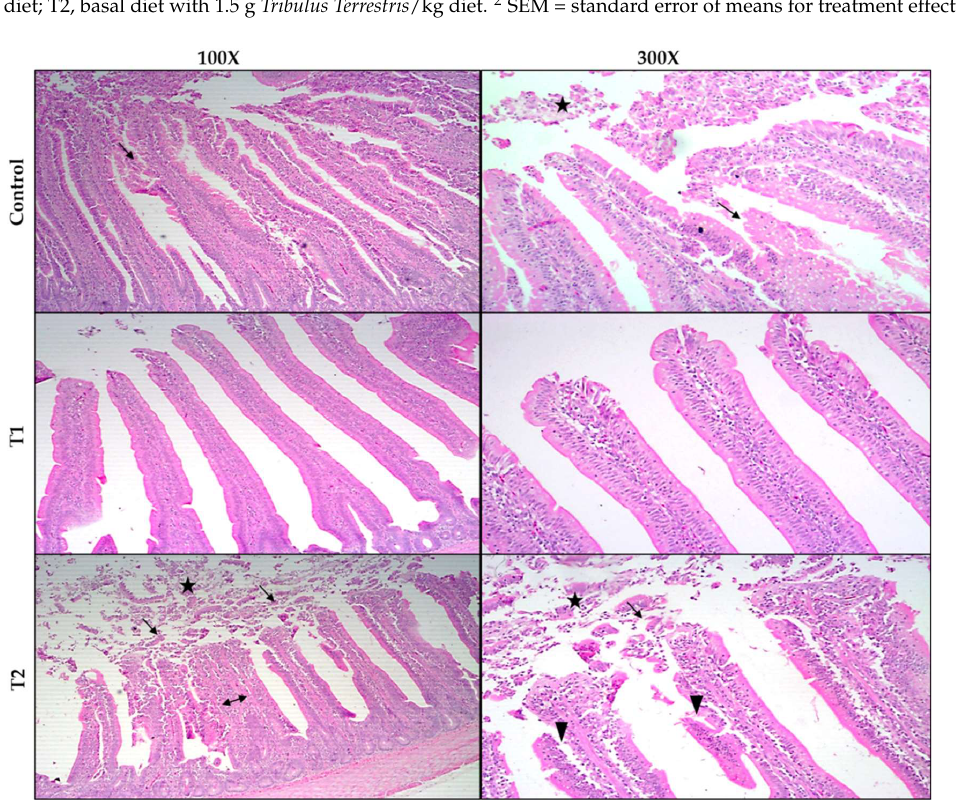
Figure 3. Histological changes in the ileum of broiler chickens stained with (H&E) 100 × to 300 × . Control, birds fed basal diet; T1, basal diet containing 0.75 g Tribulus Terrestris /kg feed; T2, basal diet containing 1.5 g Tribulus Terrestris /kg feed. Chicken ileum (control): showing normal height and width of intestinal villi with proliferative enterocytes (arrows). The lumen contains layers of epithelial cells (star). The chicken ileum (T1): normal height and width of the intestinal villi and the lumen free of any exudate and greater improvement than observed in the other treatment groups. enterocytes (arrowhead) and contain sheets of epithelial cells and mucus in the lumen (star) as well as proliferative enterocytes